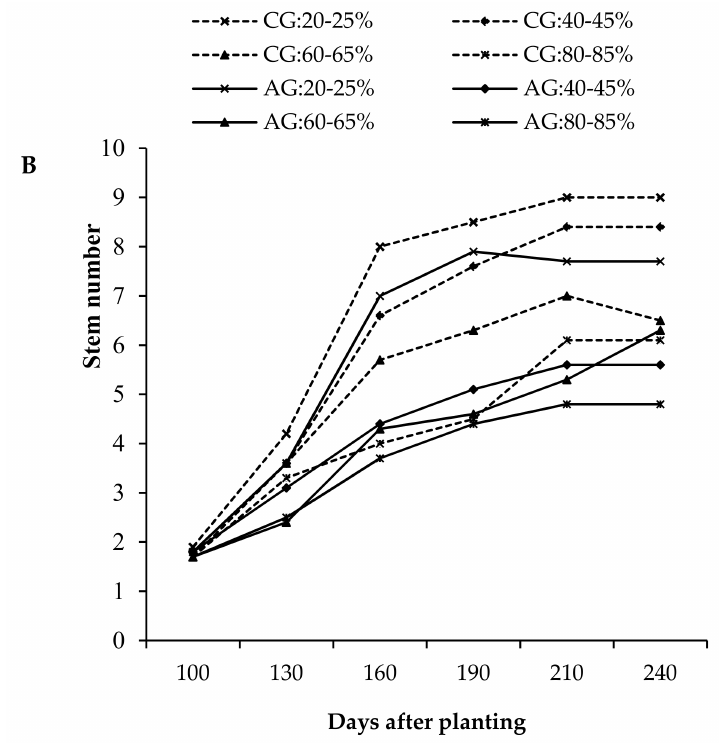
Figure 2. Number of stems per plant of two ginger species in response to different water regimes during the ( A ) 2015/2016 and ( B ) 2016/2017 cropping seasons. Where: CG: Commercial ginger; AG: African ginger; Vertical bars represent least significant difference (P ≤